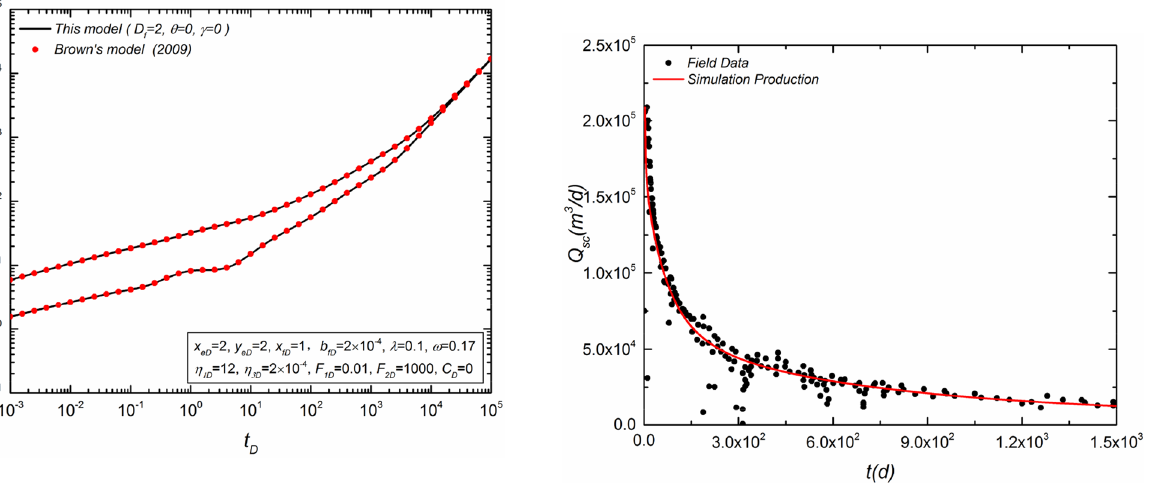
Fig. 4 Matching result of gas rate for Well